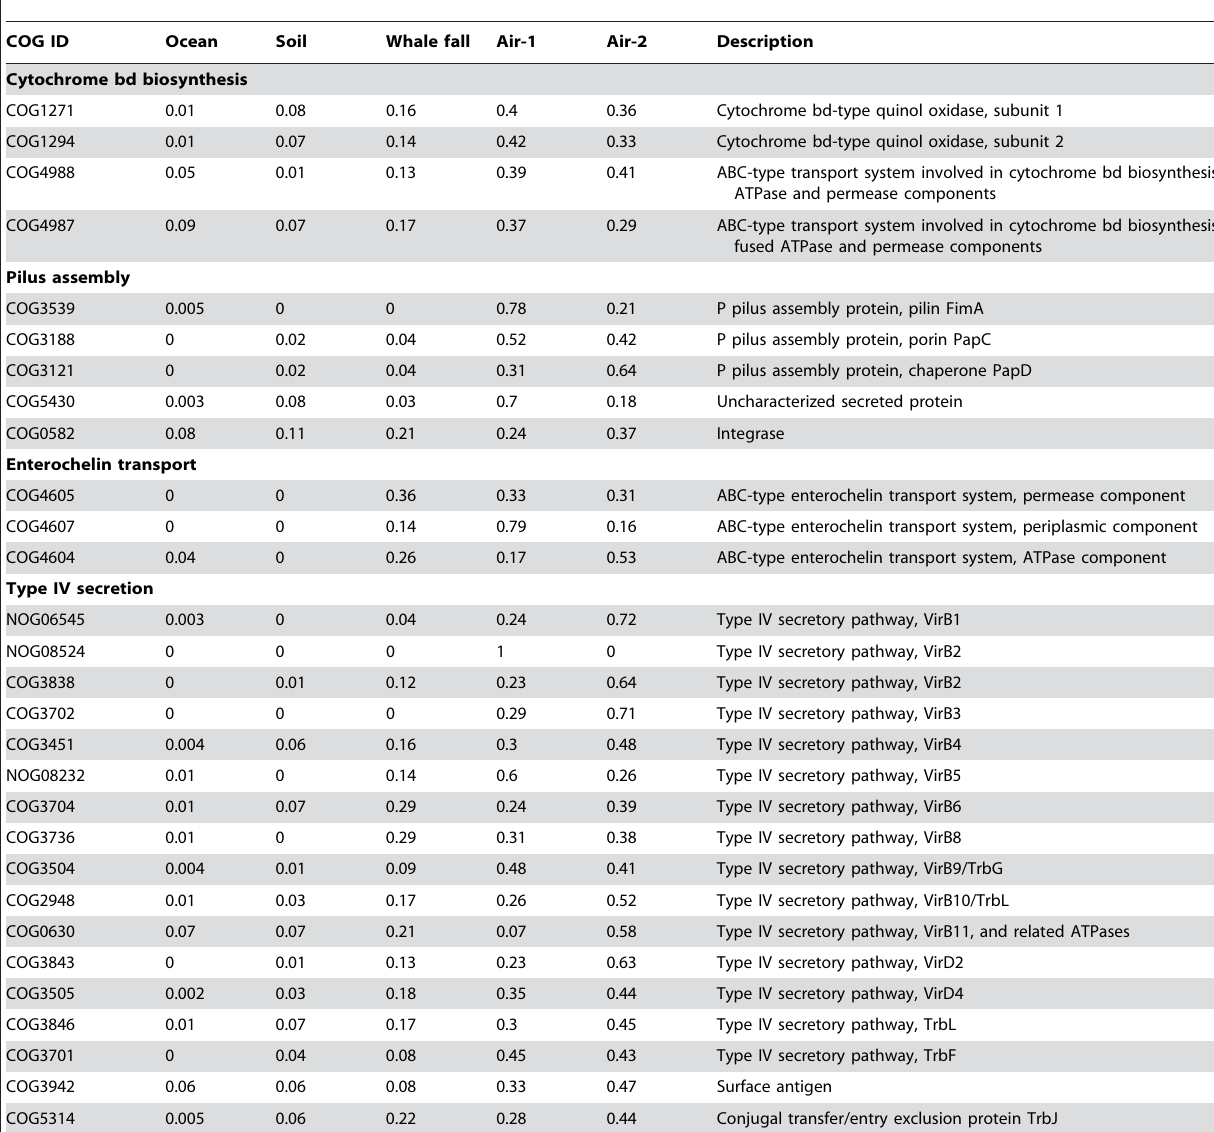
Table 2. Functionally associated gene clusters overrepresented in air and their relative abundance in other environments.